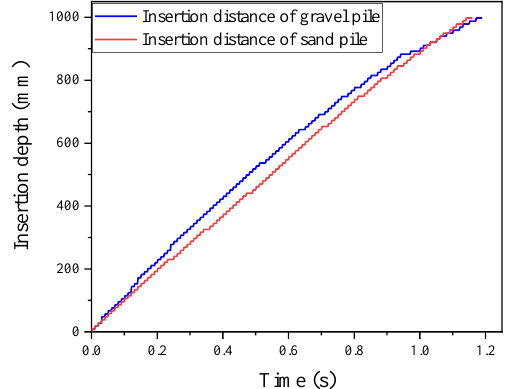
Figure 2. Insertion depth measured by the fifth wheel gauge.